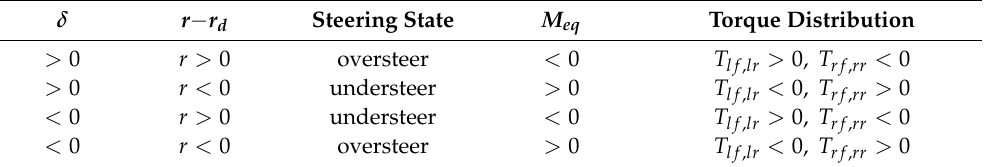
Table 2. The torque distribution